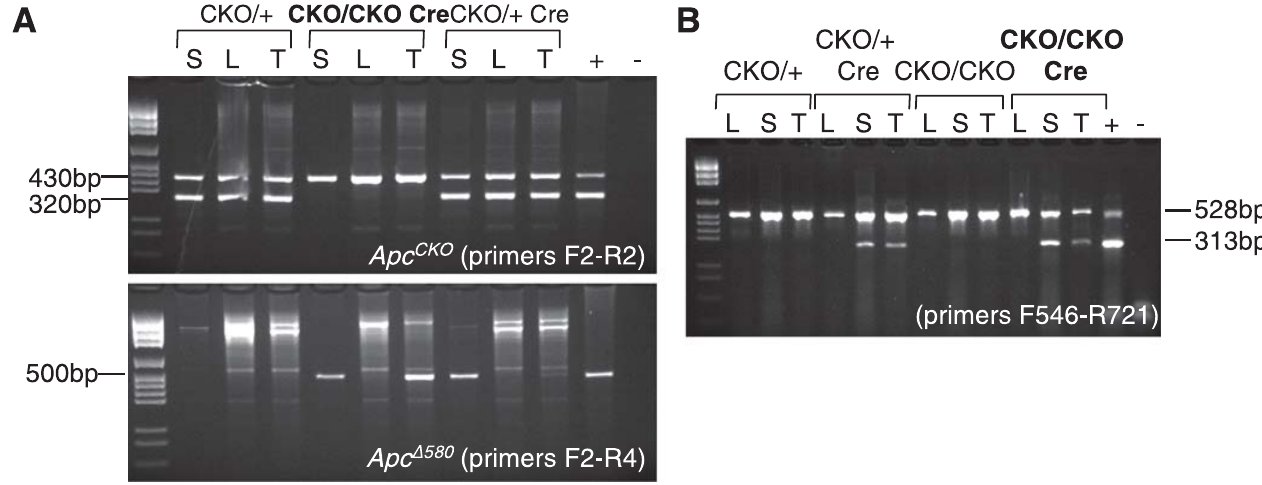
Figure 3. Tissue-Specific Detection and Expression of Deleted Apc Alleles (A) Tissue-specific genotyping PCR. Only genomic DNA samples from the skin (S) and thymus (T), but not liver (L) of mice positive for K14-cre show the presence of deleted Apc D 580 allele. ( B ) Genotype- and tissue-specific expression of the truncated Apc transcripts. A representative gel of RT-PCR using primers F546 and R721, showing that only RNA from the skin and thymus but not liver of mice positive for K14-cre have transcripts from both wild-type (528 bp) and deleted (313 bp) Apc alleles. DOI: